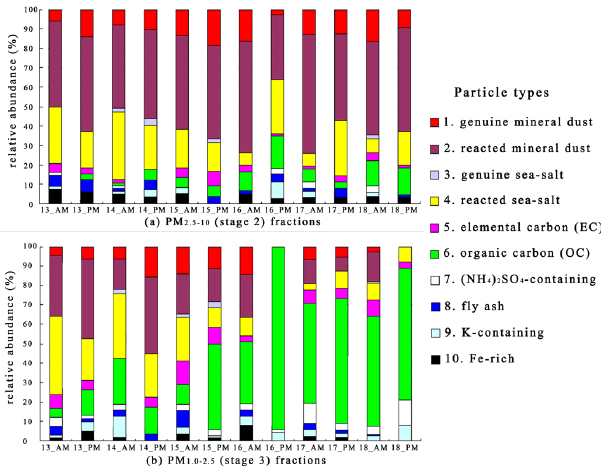
Fig. 6. Relative abundances of different particle types for the 12 sets of samples.